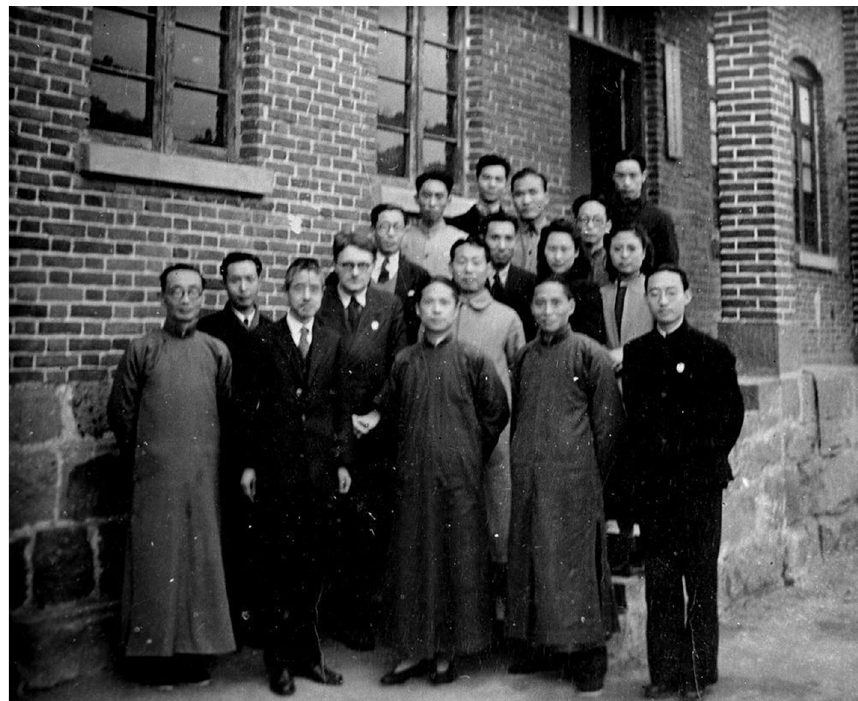
Figure 3. Dr. Jian-Kang Liu (The fi rst at the front from right), Prof. Joseph Needham (The 2nd at second raw from left), and the principal investigators in Institute of Zoology and Botany of Academia Sinica in